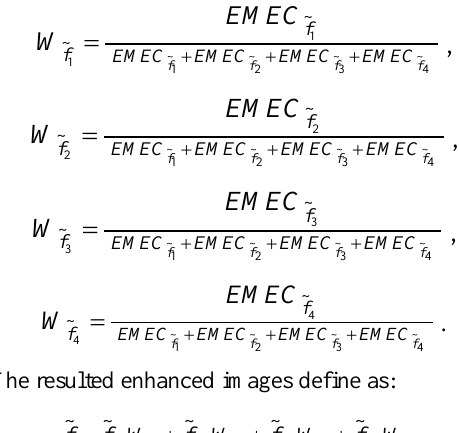
Fig.4. Enhancement results for the Image #1.